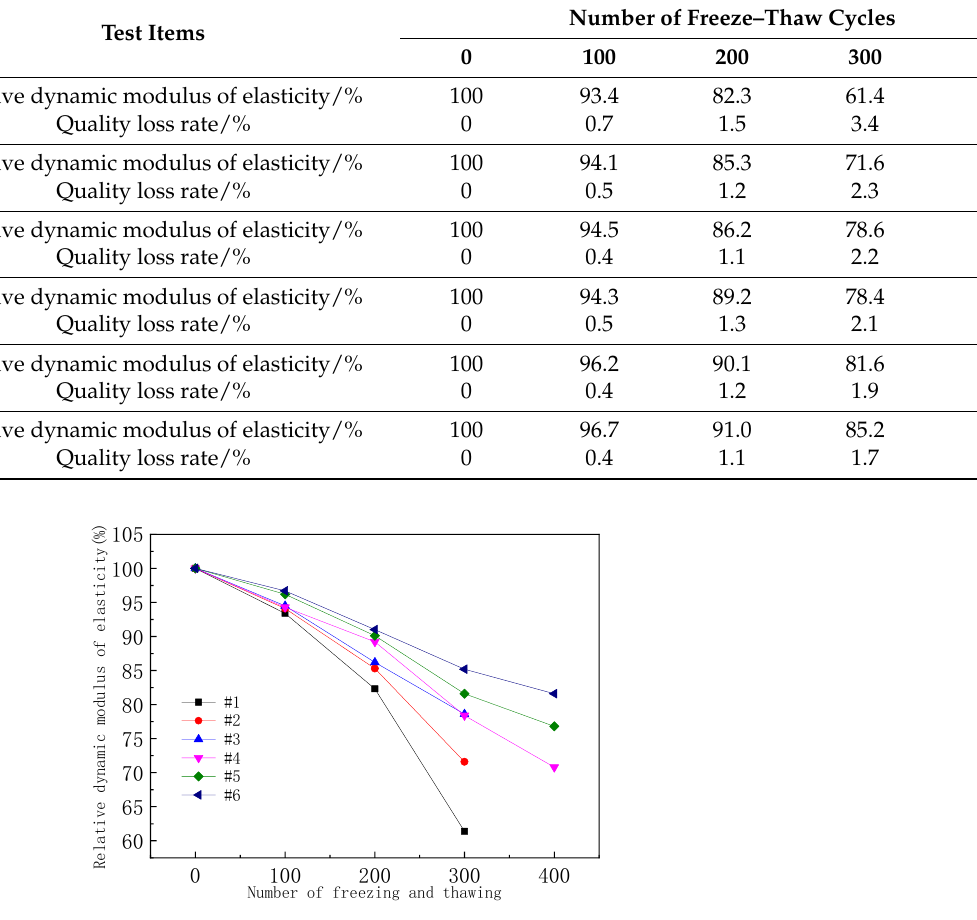
Figure 8. Relationship between the dynamic elastic modulus of concrete and the number of freeze – thaw cycles.